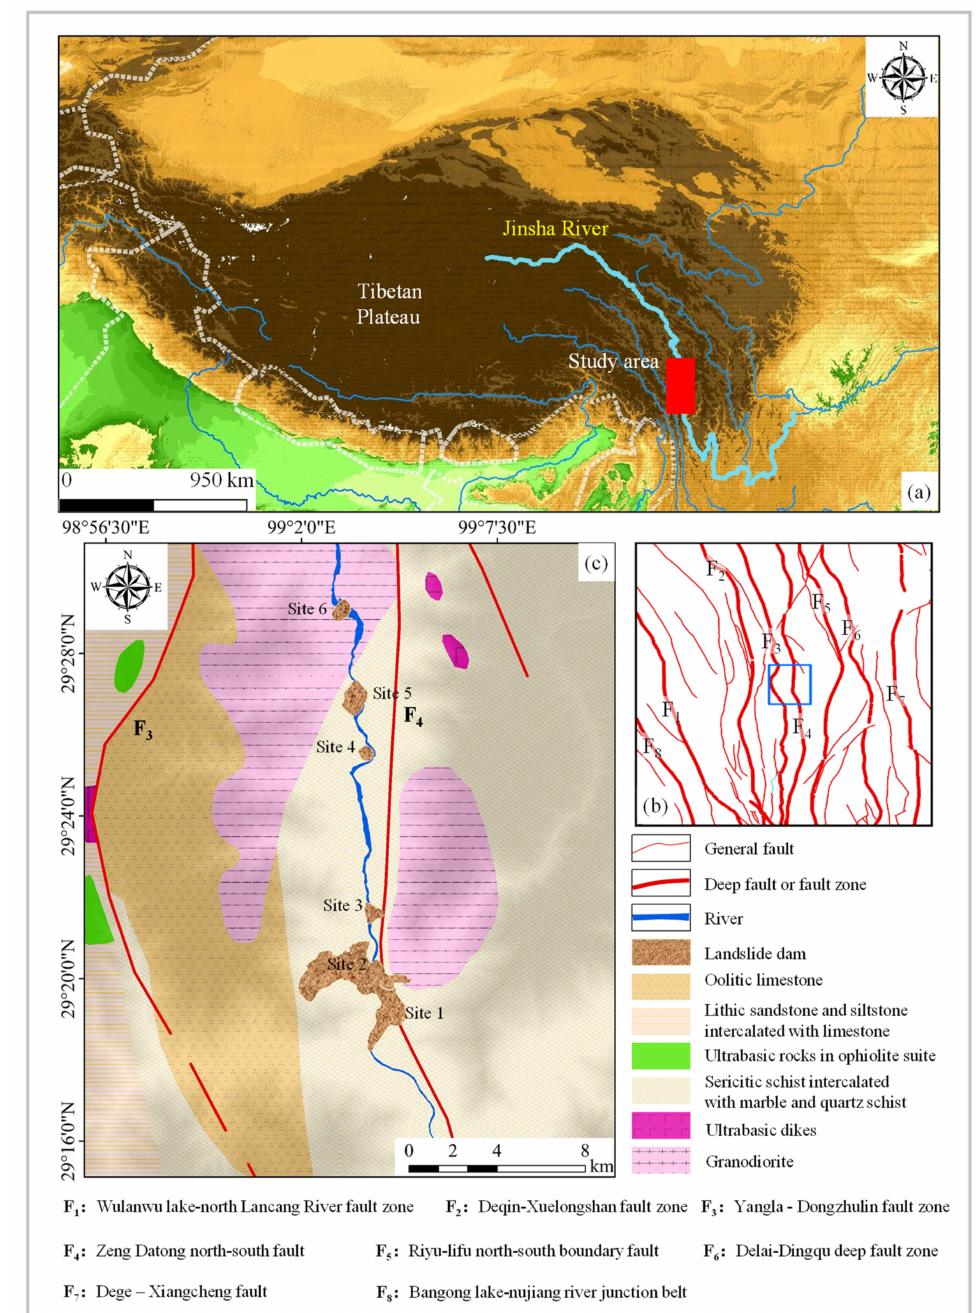
Figure 1. Map showing the locations and regional geologic settings ( a ) located on the southeastern edge of the Tibetan Plateau, ( b ) tectonic outline map (according to 1:1,000,000 geological map), ( c ) regional geological map (according to 1:1,000,000 geological